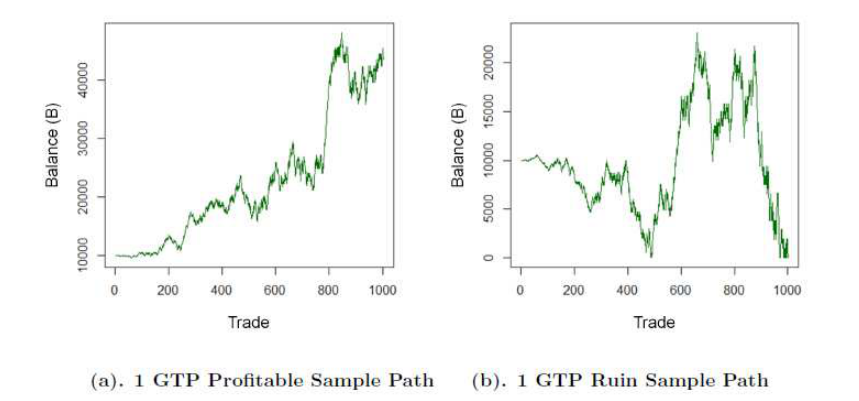
Figure 7. 2-sample GTP simulations